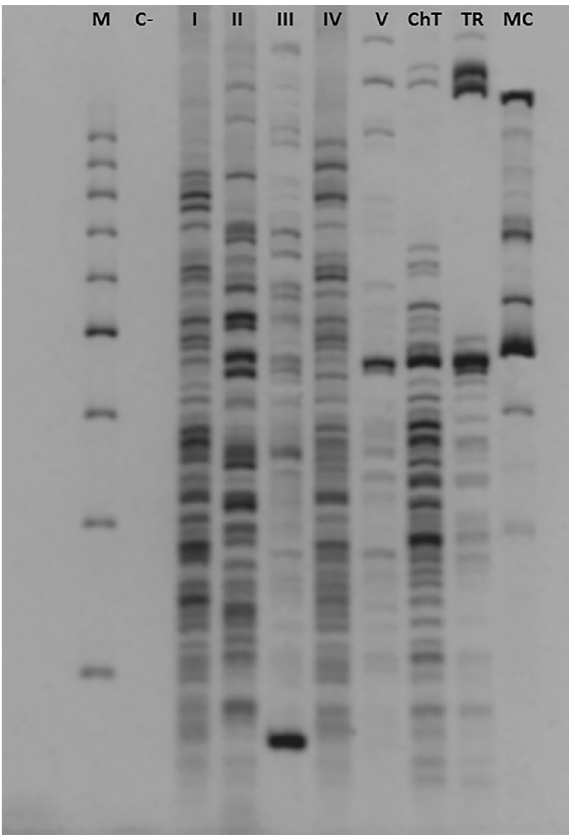
Figure 2. PCR-MP profiles of A. keratinophilus strains isolated from rook pellets using the Bam HI restriction enzyme. Electrophoresis of the DNA amplicons was carried out on a 6% polyacrylamide gel. The lane designated M contained the molecular mass marker (1000, 900, 800, 700, 600, 500, 400, 300, 200 bp); C(−) -negative control, lacking template DNA; positive controls designated ChT, Chrysosporium tropicum ; TR, Trichophyton rubrum , MC, Microsporum canis .